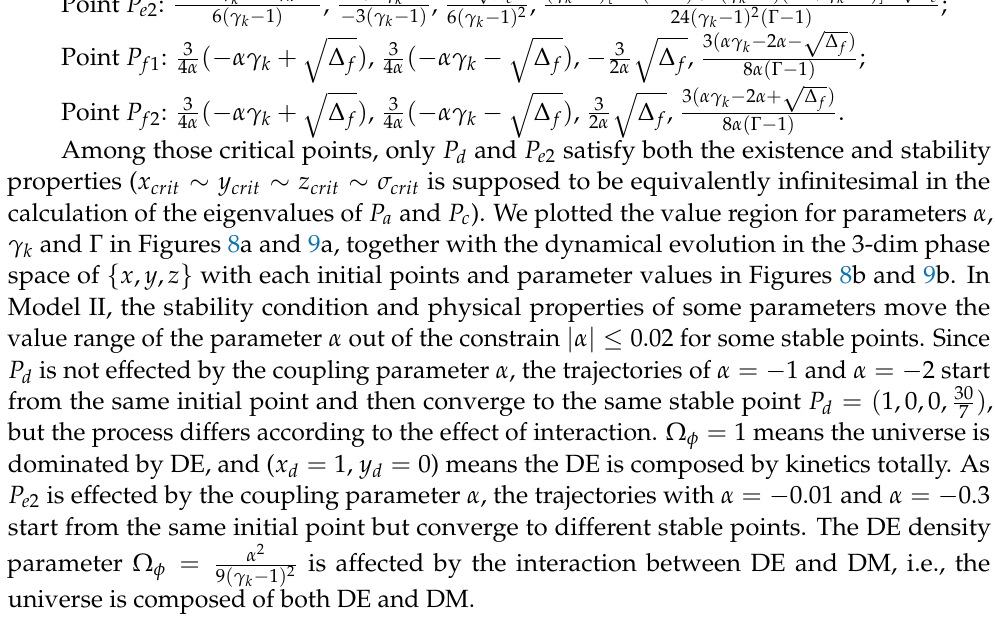
Table 2. The existence and stability conditions for eight critical points, the cosmological quantities, and the range of the parameters γ k , Γ and α for acceleration.